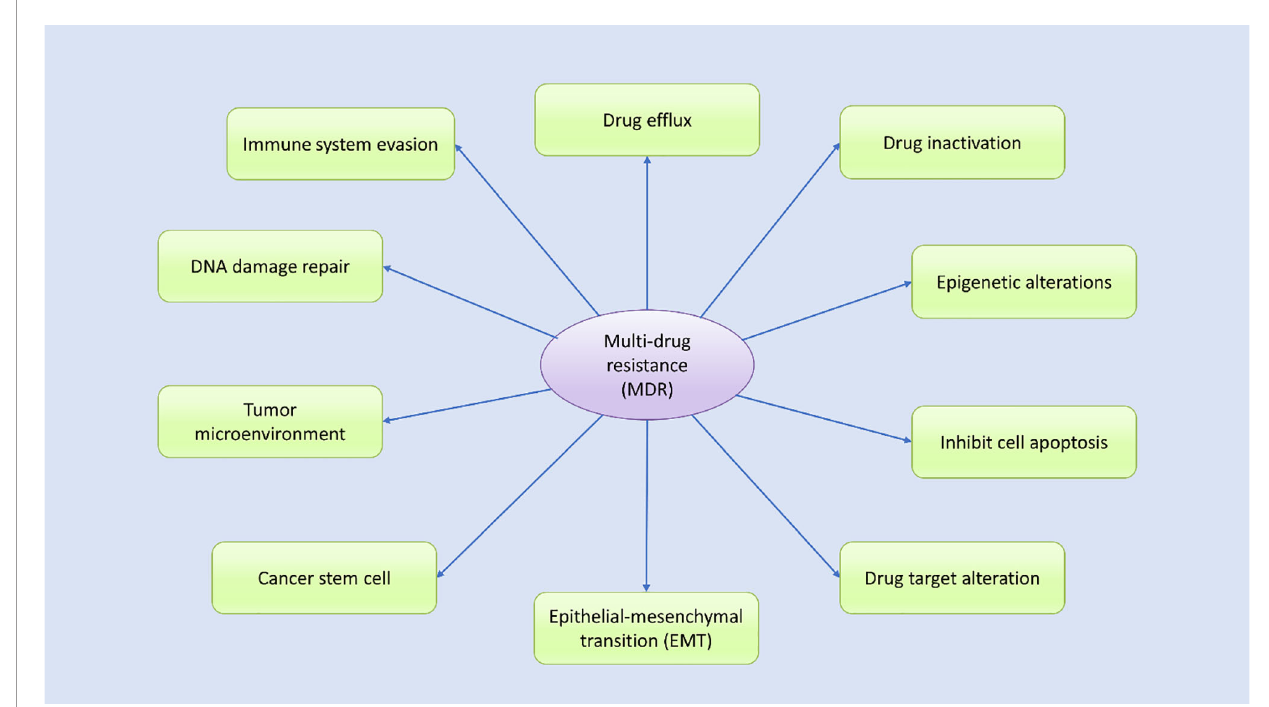
FIGURE 2 | Various potential mechanisms contribute to multidrug resistance. Many internal and external factors have been associated with the development of multidrug resistance in human cancer cells through either direct or indirect effects. Drug ef fl ux, changes in cellular drug levels, drug inactivation, altered epigenetic states, epithelial – mesenchymal transition (EMT), the tumor microenvironment, DNA damage repair, cancer stem cell propagation, and immune system evasion are well-studied mechanisms thought to contribute to MDR through various signal transduction pathways, either independently or in